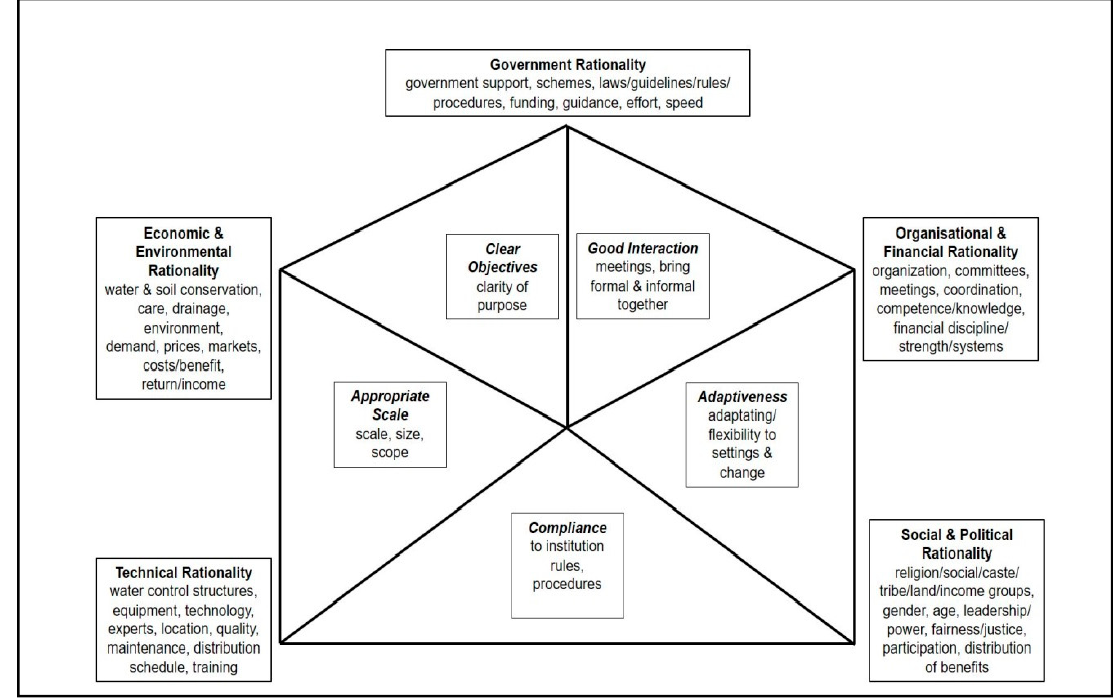
Figure 3. Conceptual Framework.